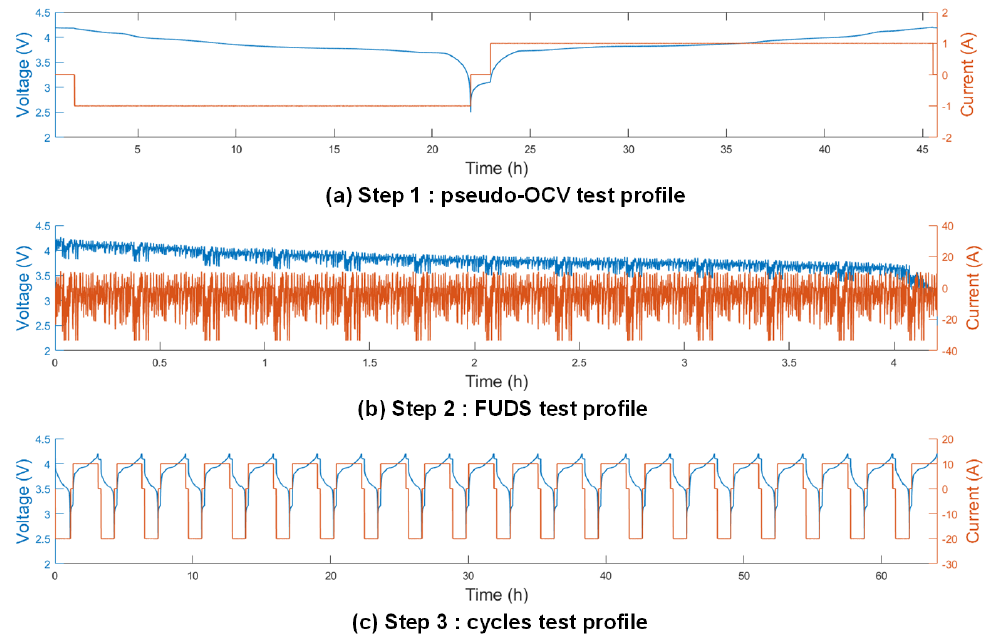
Figure 16. The three steps of experimental charging and discharging profiles .